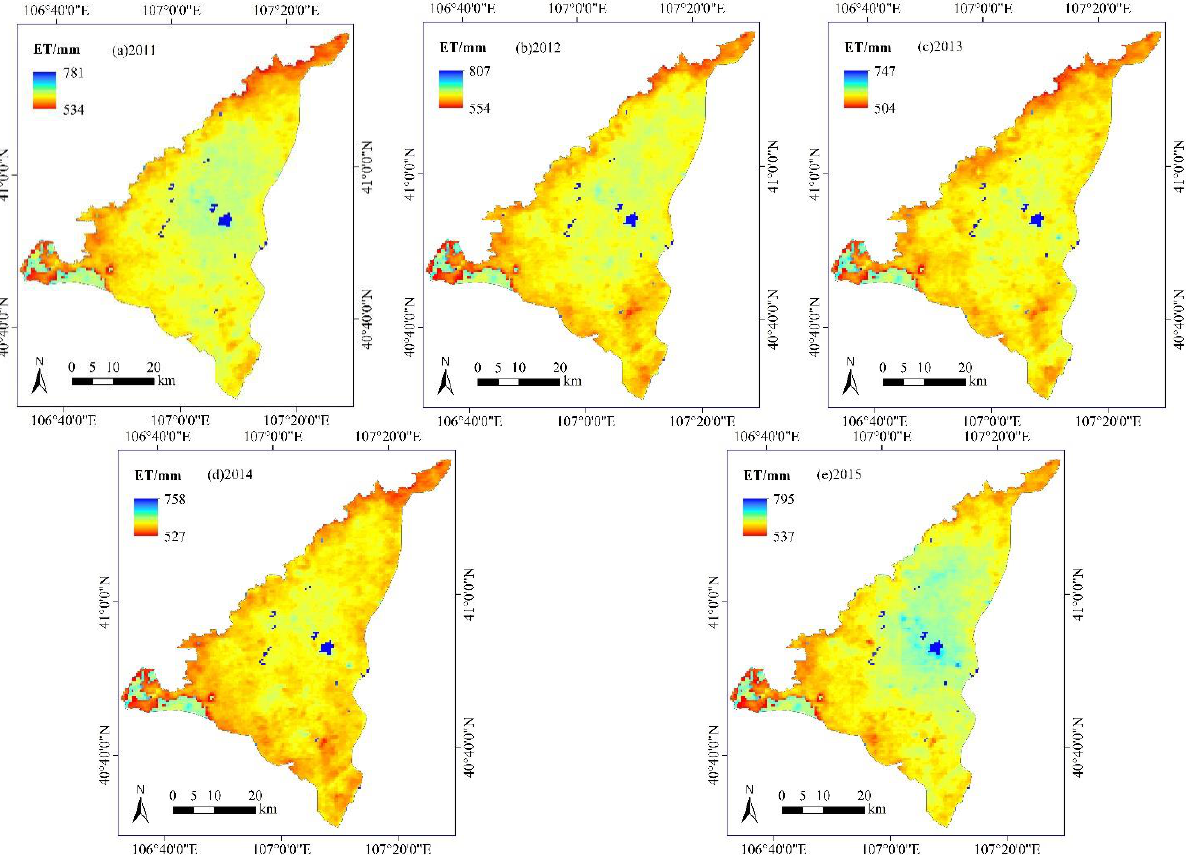
Figure 7. Spatial distribution of the annual ET in the Jiefangzha Irrigation Field. ( a ) 2011; ( b ) 2012; ( c ) 2013; ( d ) 2014; ( e )